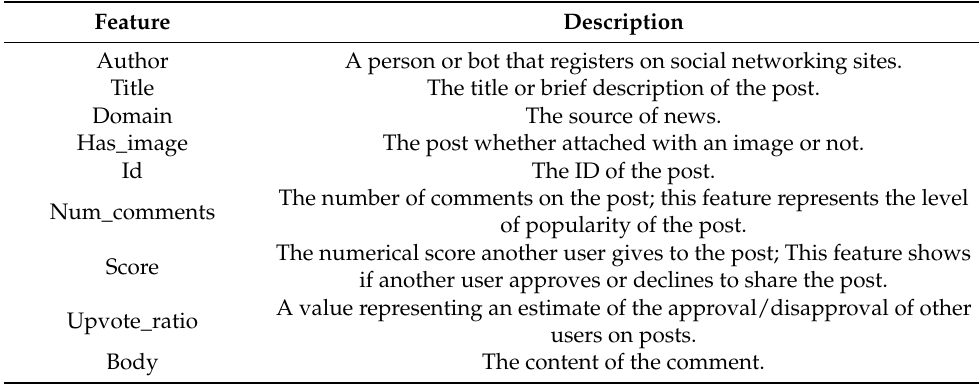
Table 2. The description of the Fakeddit